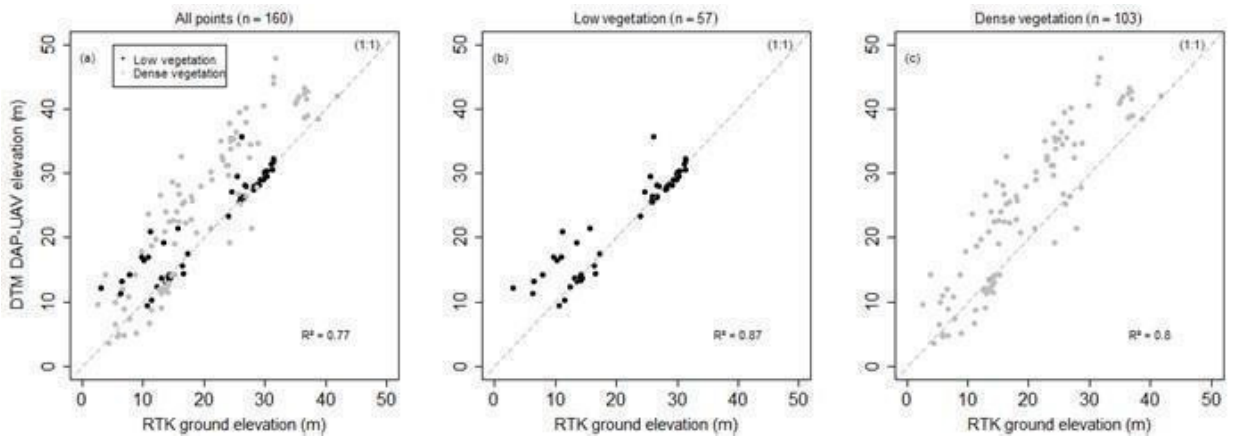
Figure 7. Scatter plots between the altitude values of the DTM generated by photogrammetry and the altitude of the terrain control points obtained by RTK, where ( a ) represents all points, ( b ) represents points in places without vegetation, and ( c ) represents points in places under vegetation.